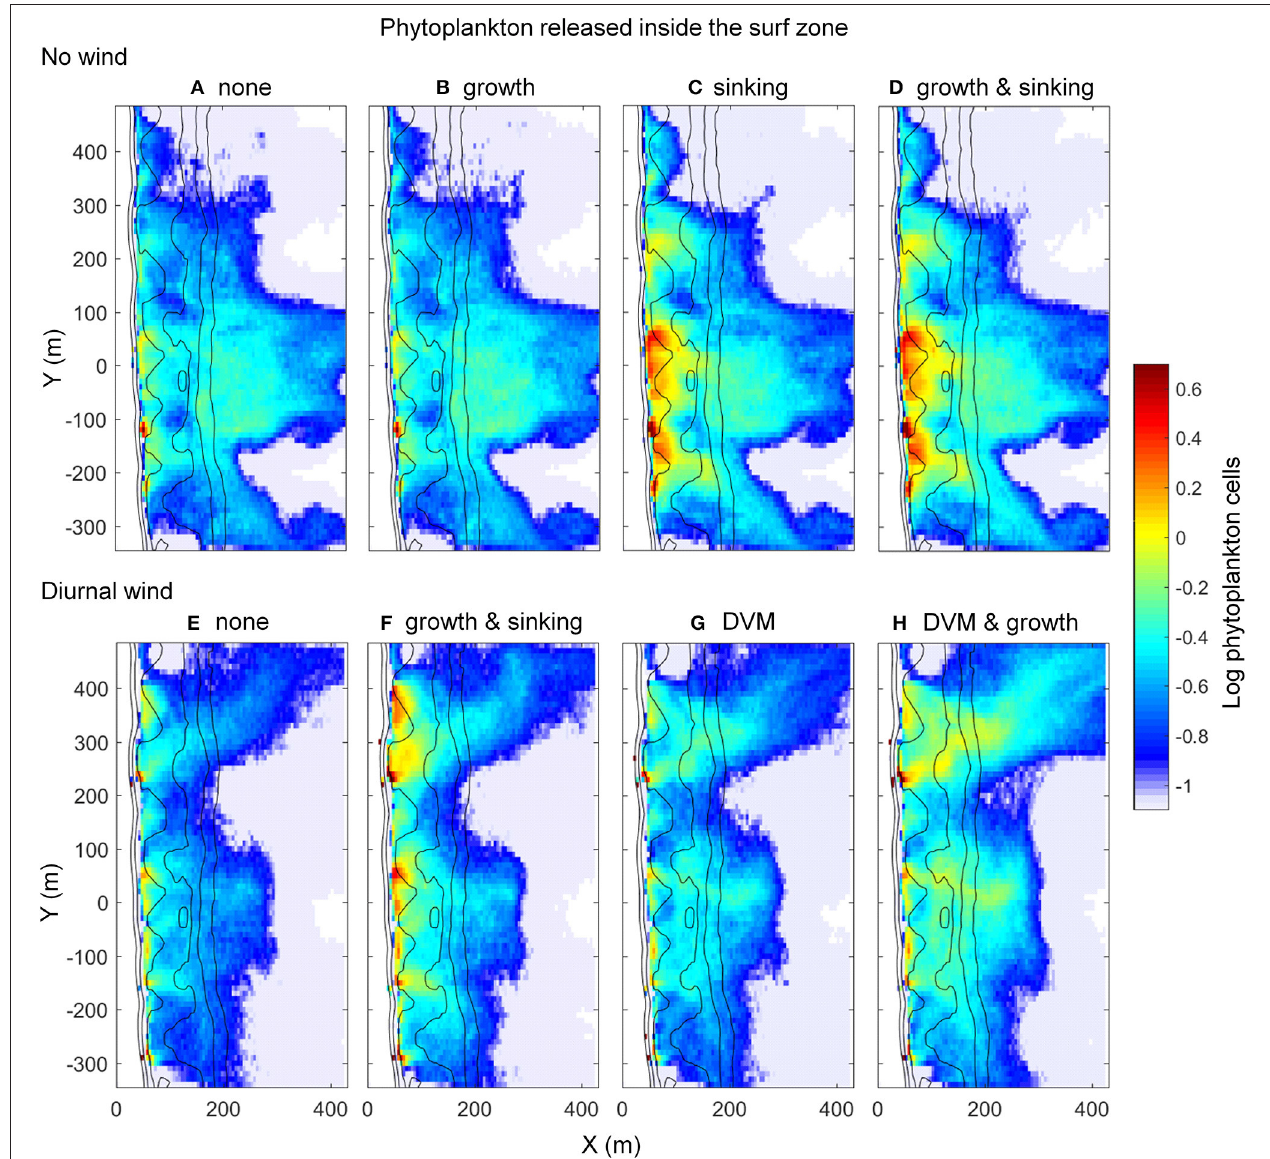
FIGURE 6 | Depth- and time-averaged number of cells per grid cell. Note that the color bar range is different form Figure 5 . Phytoplankton cells released inside the surf zone in (A–D) no-wind and (E–H) diurnal wind regime. Phytoplankton cells with (A,E) no growth, sinking, or DVM, (B) turbulence-driven growth, (C) turbulence-driven sinking, (D,F) both turbulence-driven growth and sinking, (G) DVM, and (H) DVM and depth-varying growth. Isobaths from 0m (shoreline) to 5m with 1m increments are given.